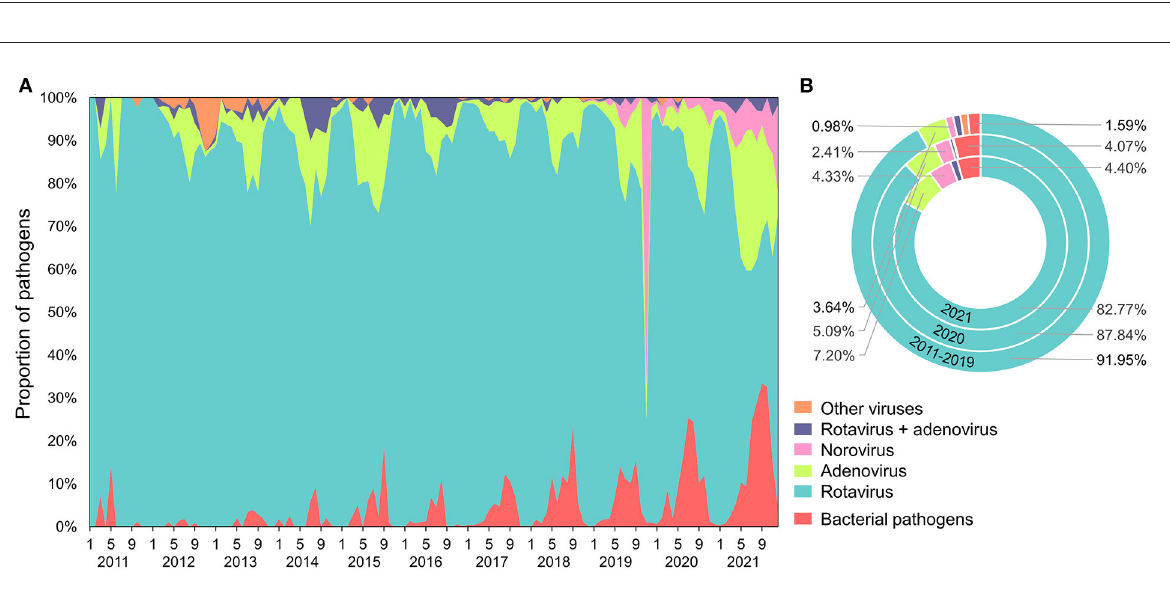
changes, and all counties also had epidemic peaks during the winter of 2020 and 2021. These differences were mostly negative during P1 (range: − 0.73–0.94, mean: − 0.41) and P3 (range: − 0.81–0.87, mean: − 0.57), but the differences were mostly